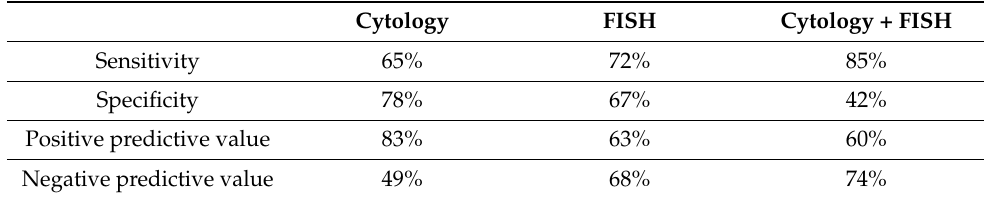
Table 4. Comparison of sensitivity, specificity, PPV and NPV.